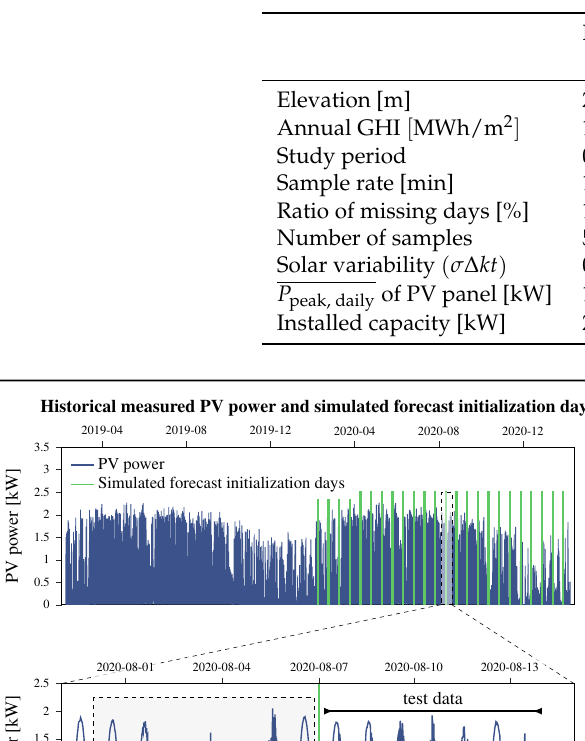
Table 1. Main information concerning the data used in this work.